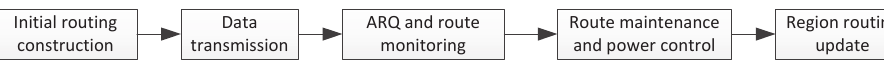
Figure 3. Overview of